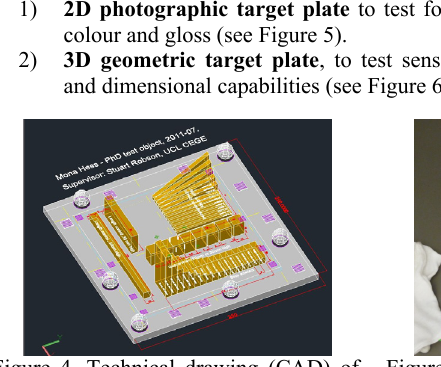
Figure 6. The 3D Geometric target plate including: step artefact; gap artefact; angle artefact and length control. At this pre-assembly stage surface treatments have not yet been